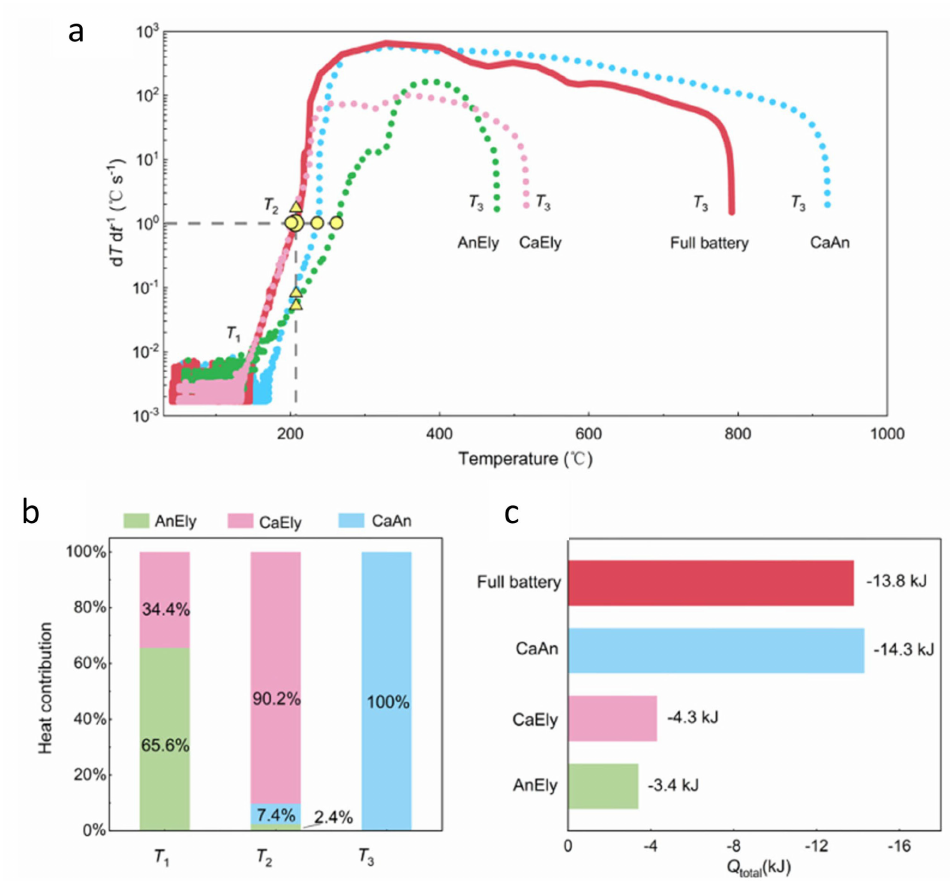
Figure 2. Reaction heat of fully charged NMC811|Gr pouch cell and partial cells during thermal runaway. Reproduced with permission Reprinted with permission from Ref. [43]. 2021,